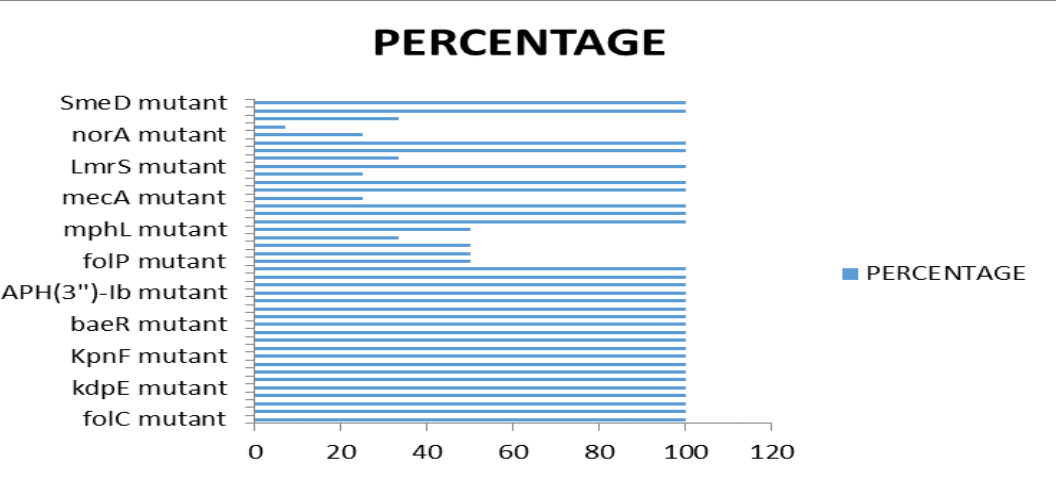
Percentage distribution of ‘strict’ resistant genes present in the complete genome of M.tuberculosis sequences Figure 4. Percentage distribution of resistant genes categorized under